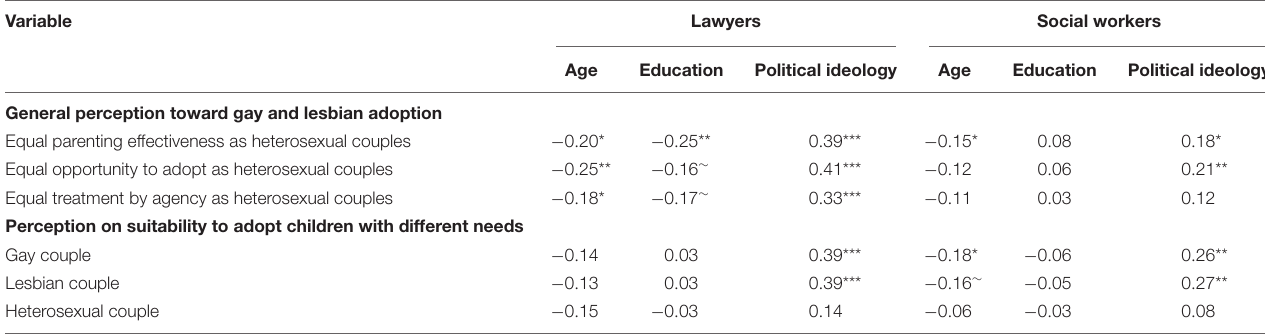
TABLE 3 | Correlations between participants’ background characteristics and their perceptions about adoption and special needs adoption by gay, lesbian and heterosexual couples ( N = 243–289).